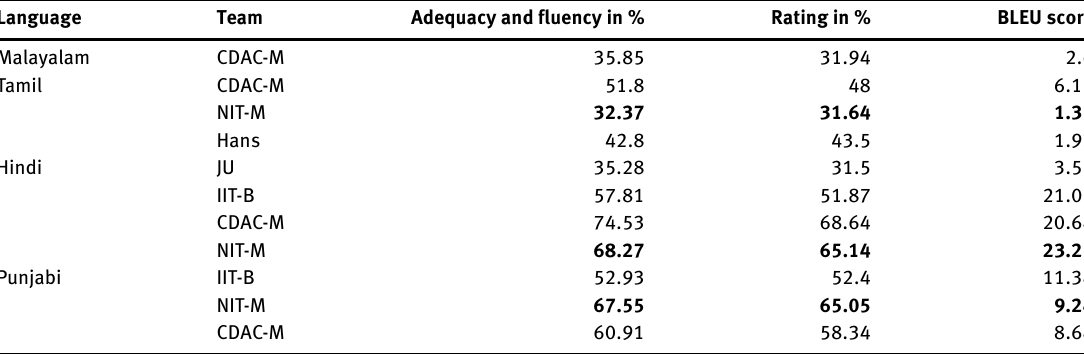
Table 5: Percentage Measures and BLEU Score.